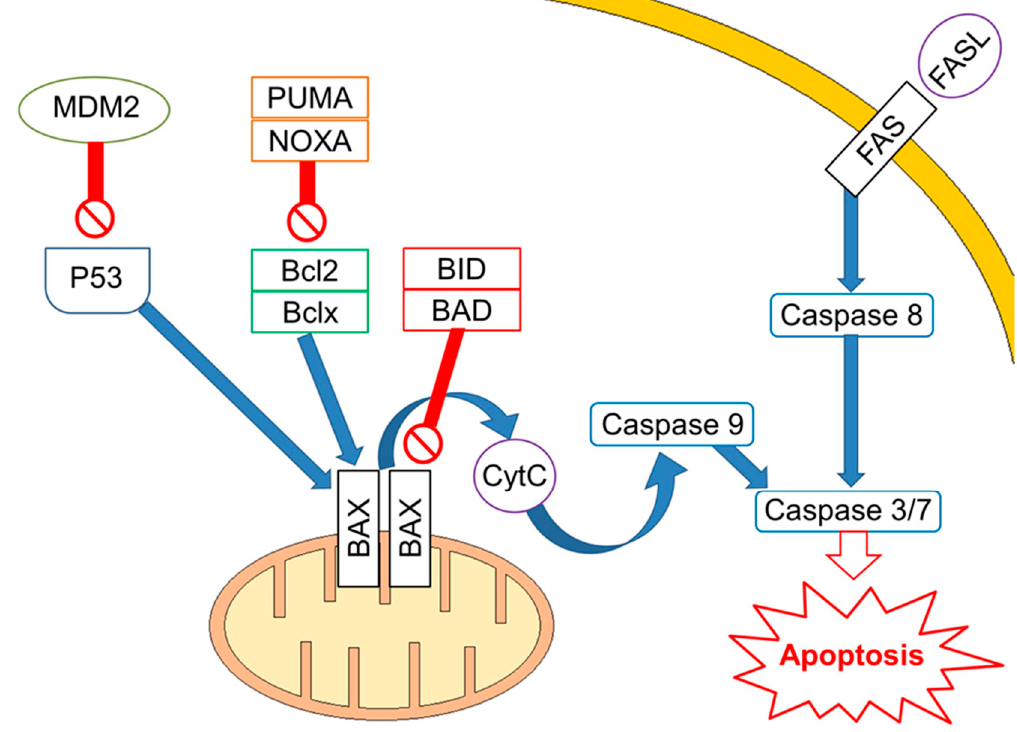
Figure 1. Apoptotic signalling in cisplatin-sensitive Germ Cell Tumours. Apoptosis is regulated at several levels with a key role for TP53, which transcriptionally regulates proteins involved in both the extrinsic and intrinsic apoptosis pathway, including FAS death receptor, BAX, PUMA, and NOXA. Activated TP53 enhances expression of the FAS death receptor. Binding of FAS ligand to FAS death receptor leads to cleavage of procaspase-8 and subsequently activates a caspase cascade leading to apoptosis. The intrinsic apoptosis pathway is regulated by pro- and anti-apoptotic proteins. Pro-apoptotic proteins directly facilitate BAX and BAK oligomerization in the mitochondrial outer membrane, or they indirectly inhibit anti-apoptotic proteins. Crosstalk between the extrinsic and intrinsic apoptosis pathways exists in form of caspase-8-mediated cleavage of